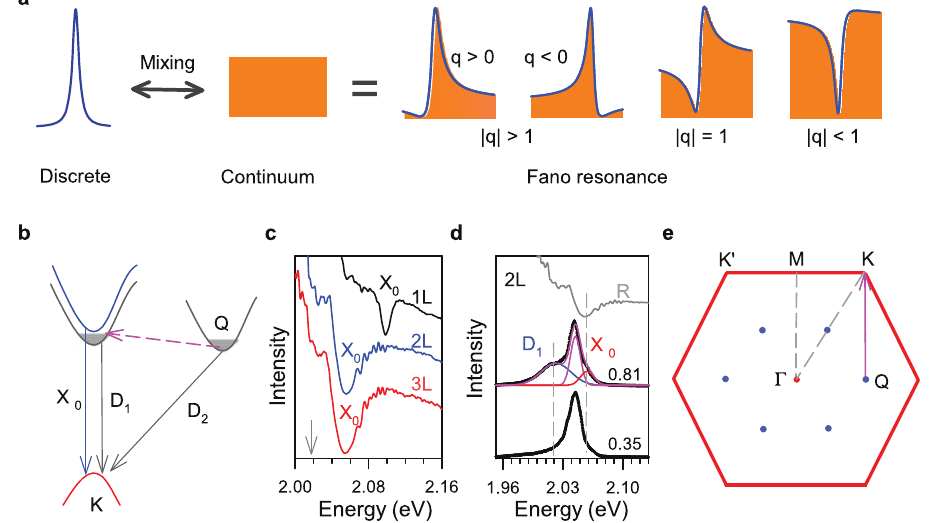
Fig. 1 | Fano-typed quantum interference and dark excitons. a Schematic dia- gram of Fano interferences between a discrete state and a continuum state. b A transition schematic diagram of the bright exciton (X 0 ), spin-forbidden dark exci- ton (D 1 ), and momentum-forbidden dark exciton (D 2 ). c Re fl ection spectra of 1-3L WS 2 (S1) at 4 K. d PL spectra of hexagonal boron nitride encapsulated bilayer WS